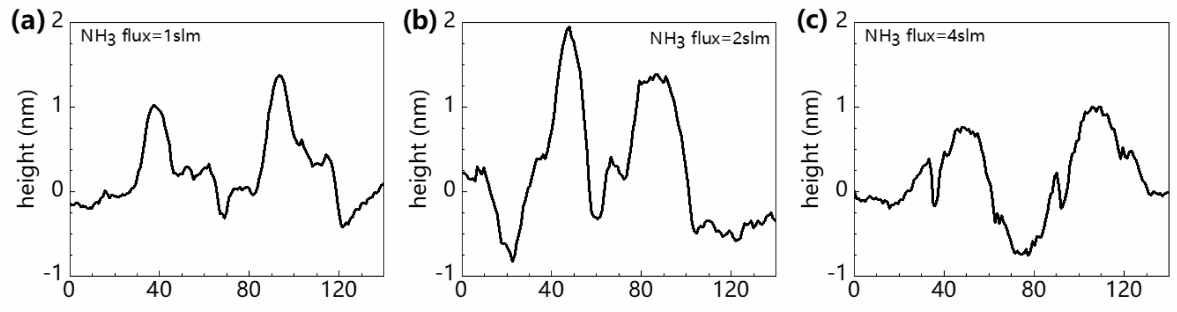
Figure 6. Height distribution at a cross section of the surface near white spots in AFM results for samples S1 ( a ), S2 ( b ), and S3 ( c ), correspondingly.